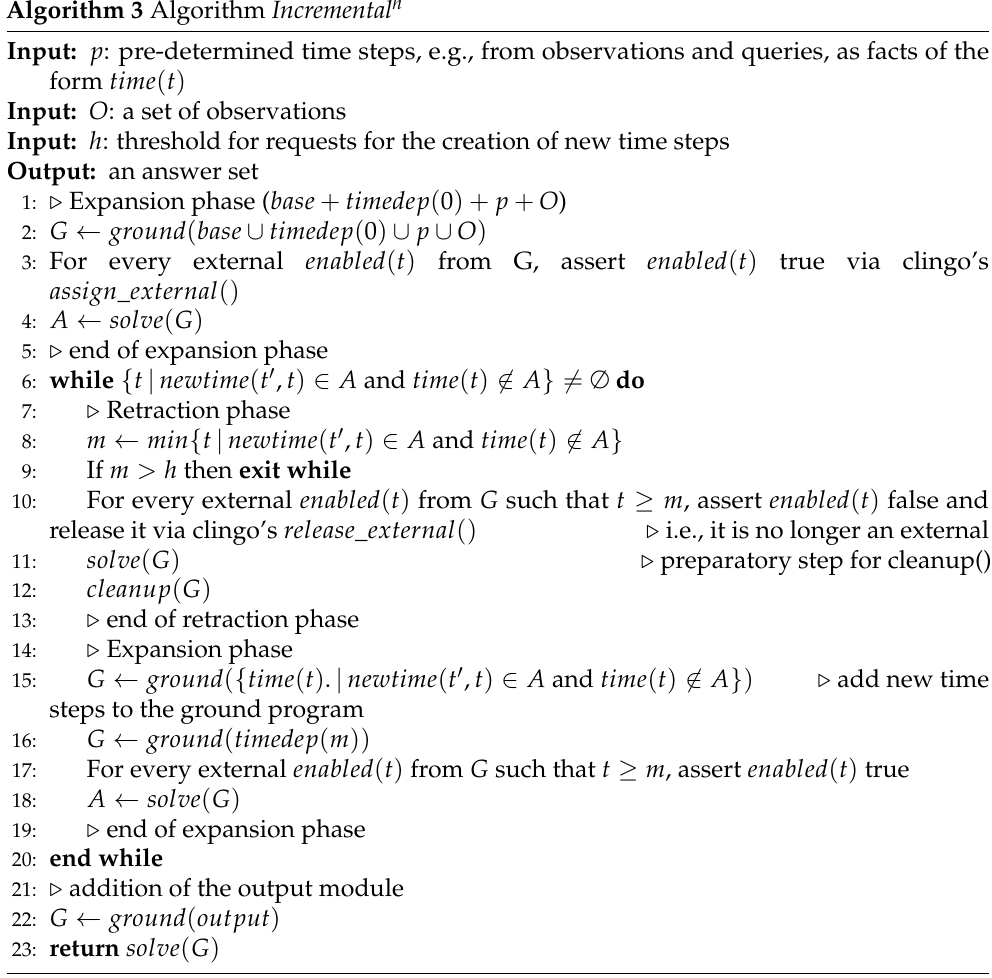
Algorithm 3 Algorithm Incremental